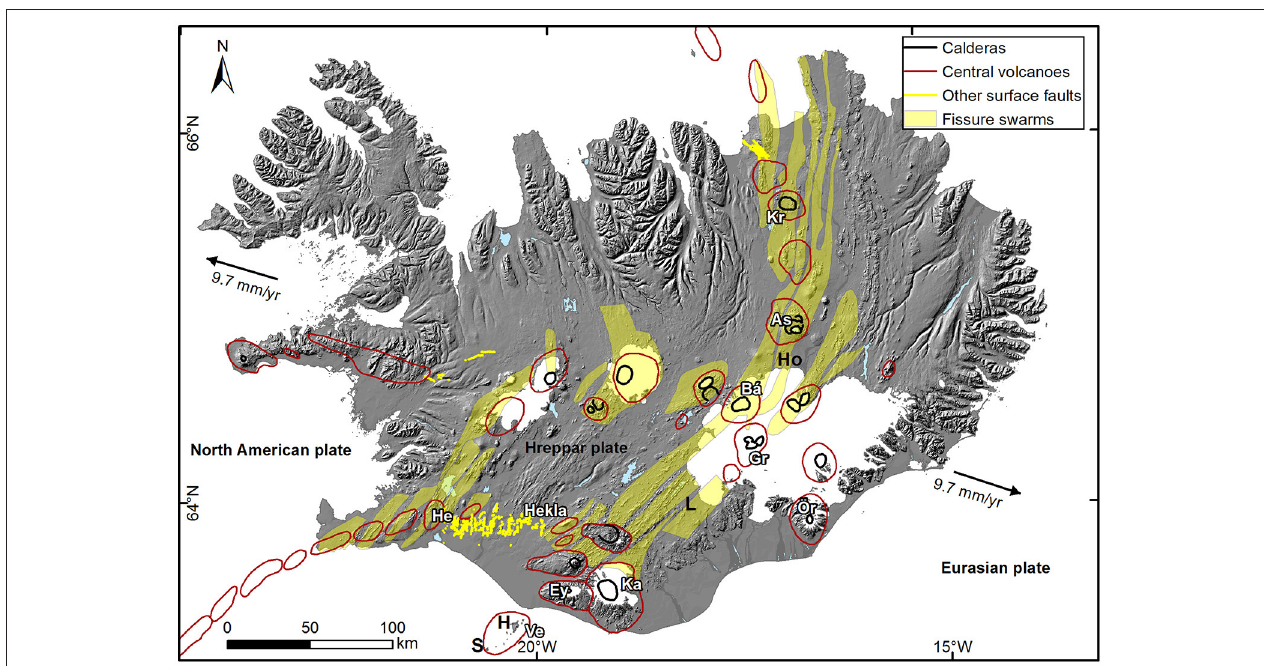
FIGURE 1 | A map showing the neo-volcanic zones of Iceland and the active volcanic systems: Kr Krafla, As Askja, Bá Bárðarbunga, Gr Grímsvötn, Ör Öræfajökull, Hekla , Ka Katla, Ey Eyjafjallajökull, Ve Vestmannaeyjar, He Hengill. Eruption sites are also shown: Ho Holuhraun, H Heimaey, S